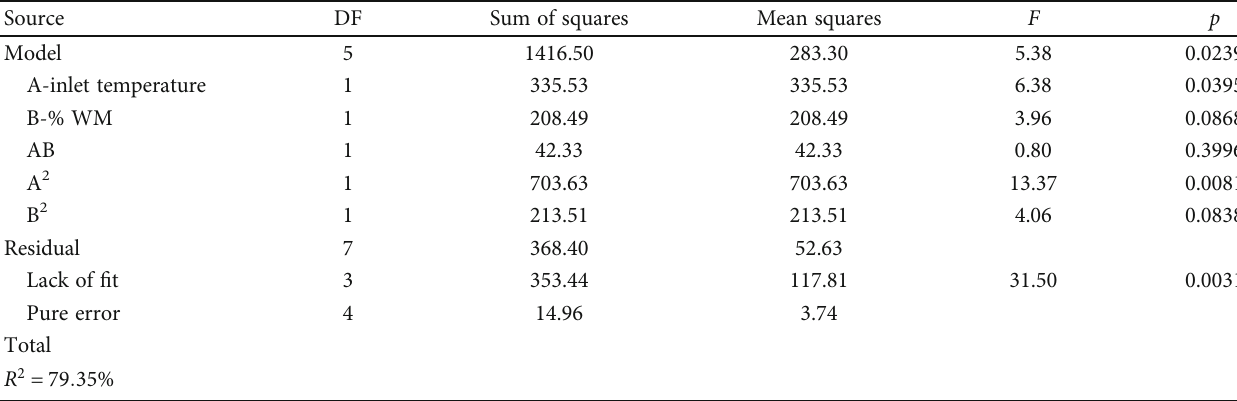
Table 5: Analysis of variance of the e ff ect of temperature ( ° C) and wall material (%), adjusted to a quadratic model on the yield (powder recovery rate) of the encapsulation process.